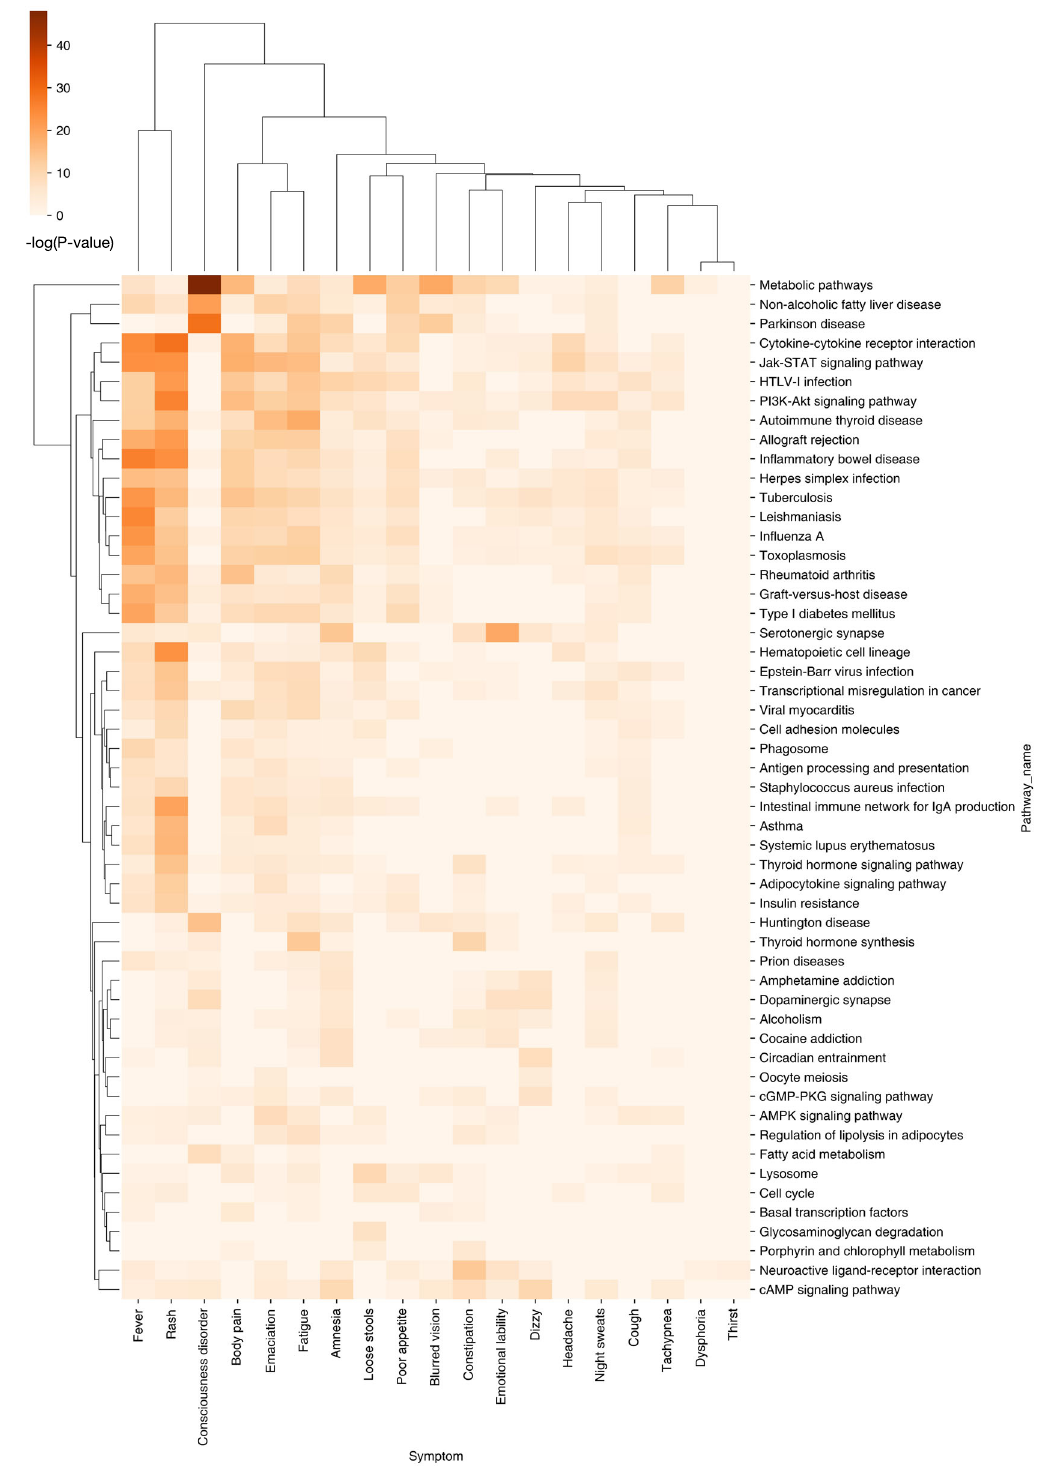
Fig. 6 The overlapped pathways of insomnia symptom clusters. The enriched KEGG pathways is evaluated by P -value with